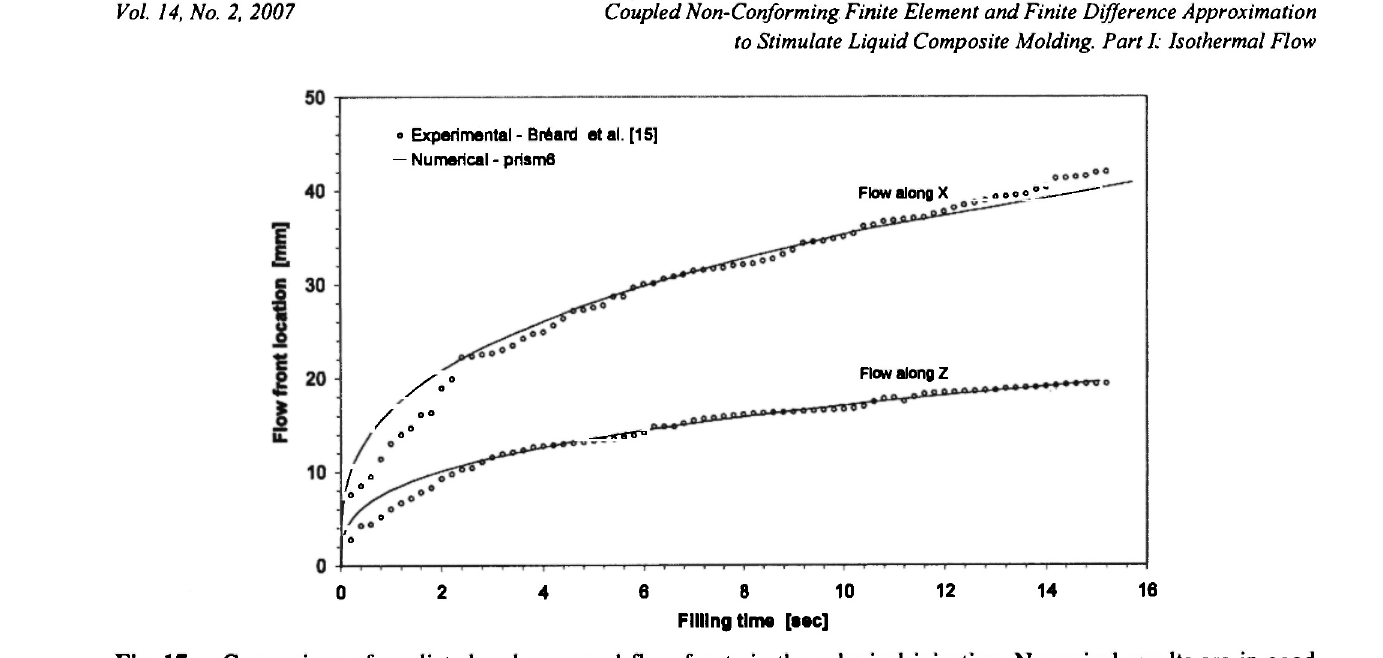
Fig. 17: Comparison of predicted and measured flow fronts in the spherical injection. Numerical results are in good agreement with experimental